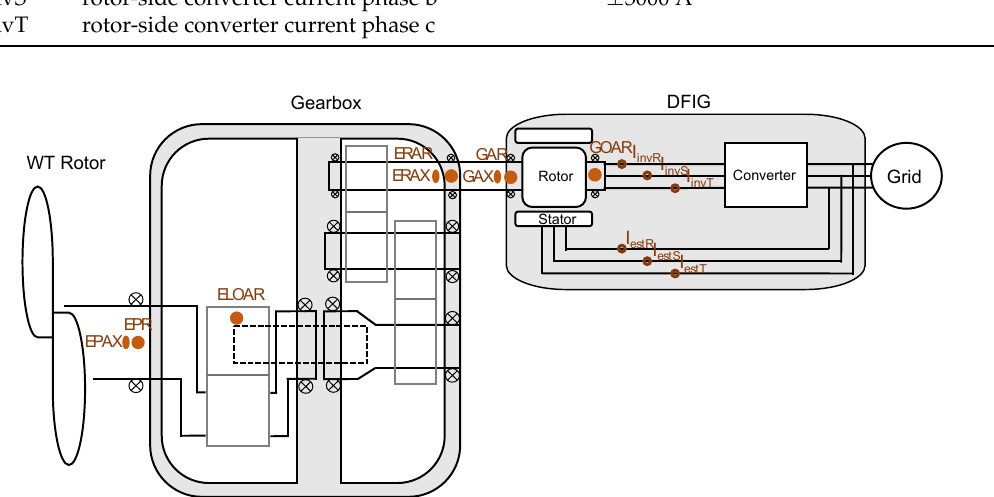
Figure 2. Location of sensors on in-service wind turbine drive